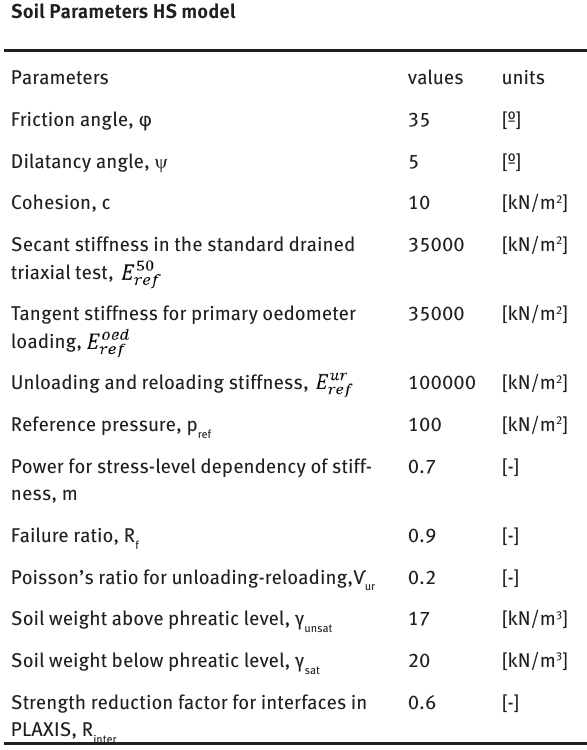
Table 2: Soil parameters adopted in the numerical analysis (from Miro et al.